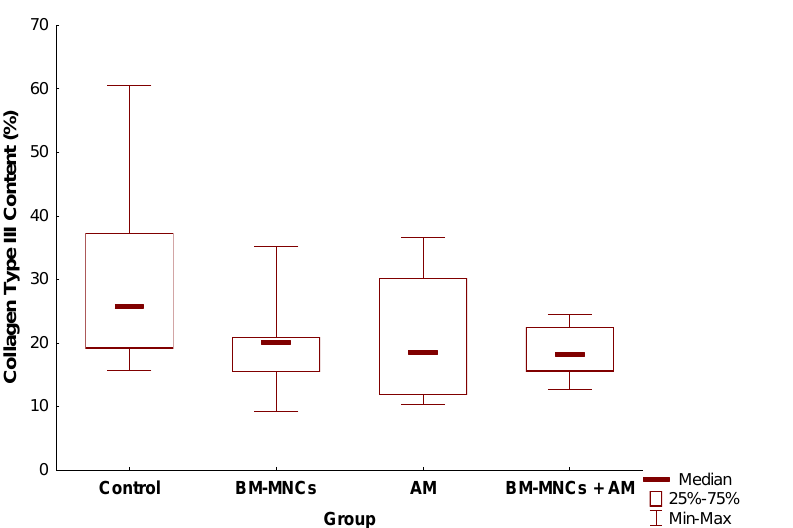
Figure 10. Collagen content analysis and flap skin area after 28 days. Collagen deposition quantified as Picrossirius Red positive areas, control group; Collagen type III content BMSCs group. Collagen type III content, acellular amniotic membrane. Collagen type III content, bone marrow mononuclear stem cells + acellular amniotic membrane group. Arrows indicate collagen type III. Results are shown as mean ± standard deviation. p < 0.0001. Images 20×, scale bar = 20 μm.